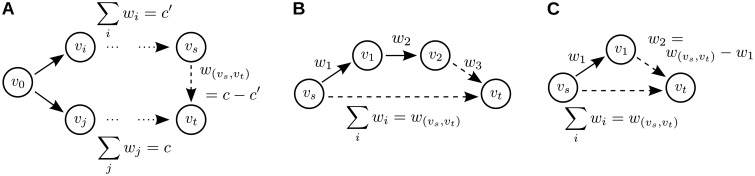
Spurious Interactions.(A) Common drive effect: A spurious interaction due to common drive may be potentially present if the processes at vertices v
s and v
t are driven by v
0 with differential delays, such that the bivariate information transfer between v
s and v
t is a result of the common input from v
0; (B) Cascade effect: Spurious interaction due to cascade effects may be potentially present for all cascades of information transfer in a “chain” of sources. In the example here, the bivariate information transfer between v
s and v
t (edge (s, t)) can be explained by an alternative routing of information via vertices v
1 and v
2. The summed weight of the alternative routing is equal to w
(s,t); (C) “Triangle” motif: This is the most simple motif potentially giving rise to either of the above spurious interactions: (v
s, v
t) could be a result of a cascade effect with respect to the path 〈v
s, v
1, v
t〉, and (v
1, v
t) could be the result of a common drive of v
1 and v
t by v
s. At most one of these interactions can be spurious.